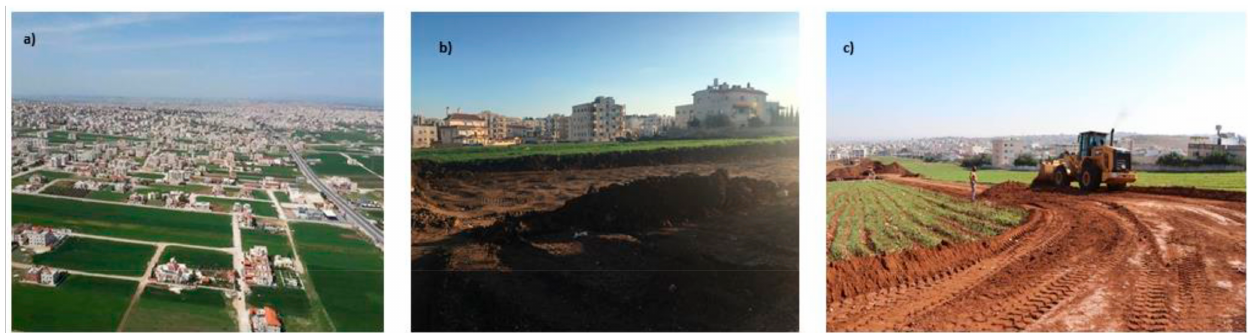
Figure 10. ( a ) Bird’s view image of the southern side of GIM showing leapfrogging pattern in GIM area (photo taken in 27 2017; courtesy of pilot Mohammad Al-Zoubi; ( b ) Preparation for constructing a Multi-housing unit on the fertile red soil 28 in Idoon (photo taken by the author in April 2017); ( c ) New road construction through cultivated land in Hoson (Photo 29 taken on 18 November 2020; courtesy of Greater Irbid